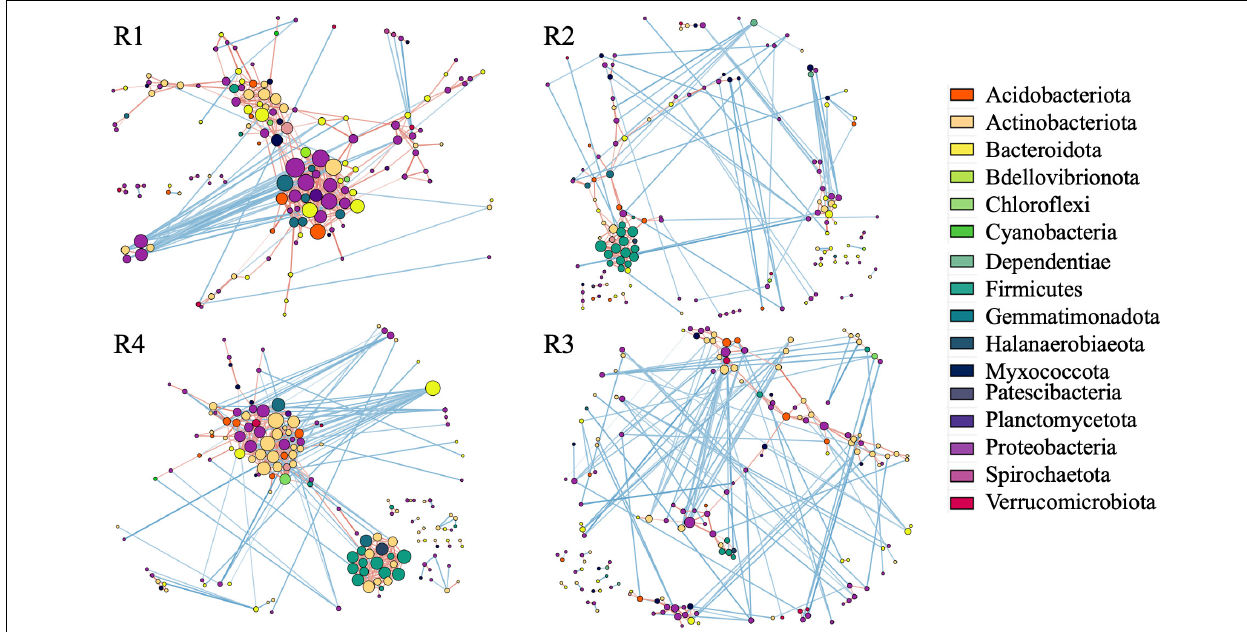
FIGURE 6 | Correlation base network analysis showing potential bacterial interactions. The size of the node is proportional to a taxon’s degree (the number of edges connected to the node). The lines that connect nodes (edges) represent positive (red) or negative (blue) co-occurrence relationship. The intensity of the color and the length of the edges represent the strength of correlation. R1—inculcated roots and R2—non-inoculated roots 3 months post-inoculation, R4—inculcated roots and R3—non-inoculated roots 1 year